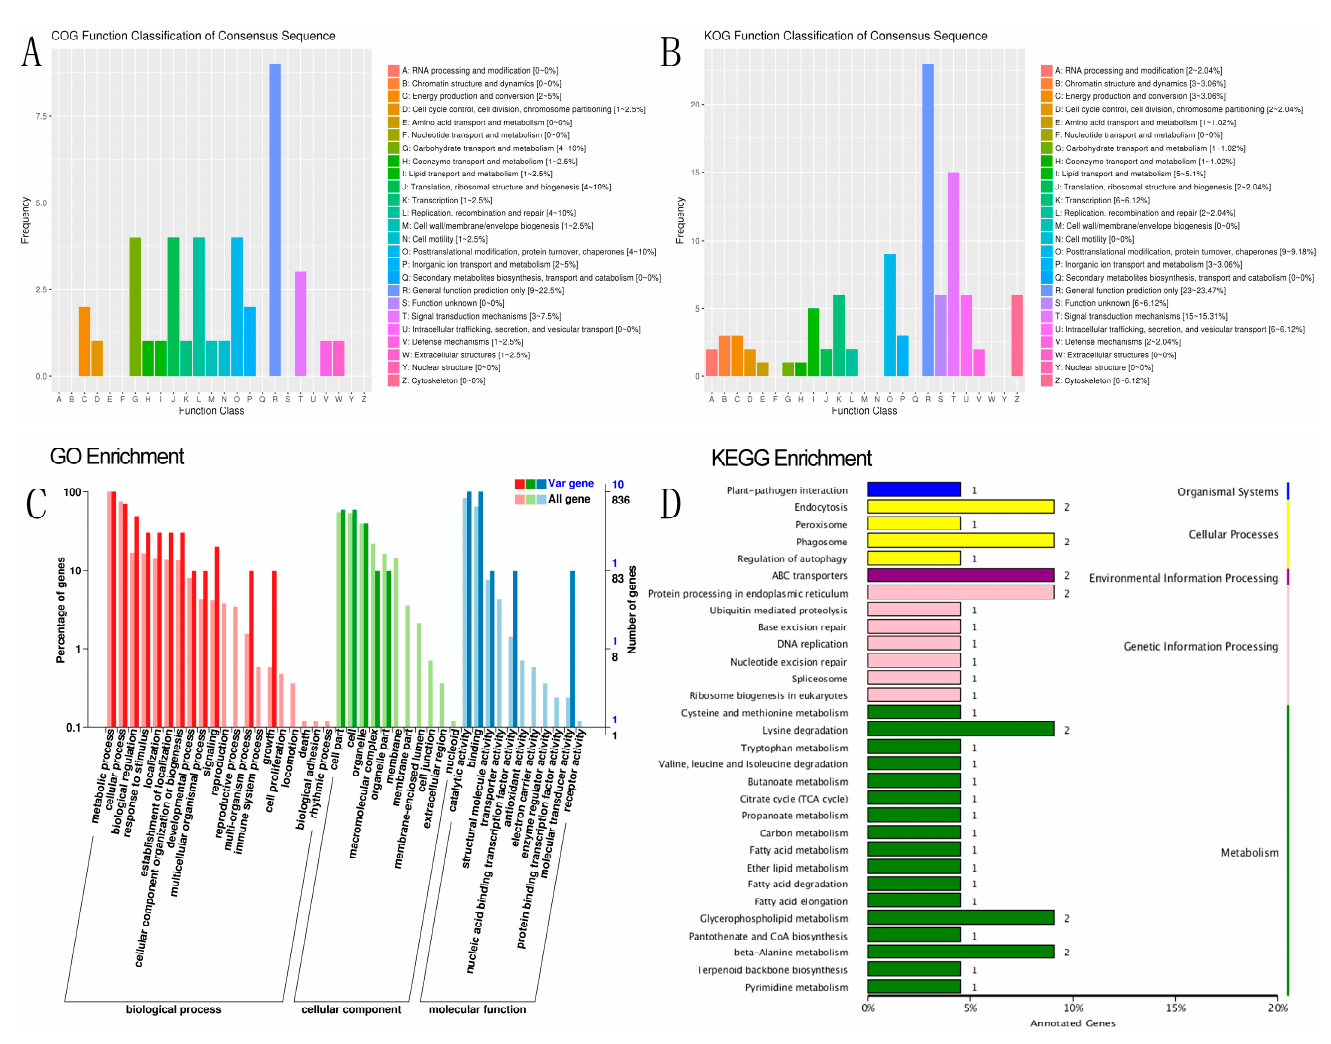
Figure 5. ( A ) Clusters of Orthologous Genes (COG); ( B ) Gene Ontology (GO); ( C ) KOG (Eukaryotic Orthologous Groups)), and ( D ) Kyoto Encyclopedia of Genes and Genomes (KEGG) of top 5% population differentiation index (F ST ) and nucleotide polymorphisms ( π ) in A. c. cerana .